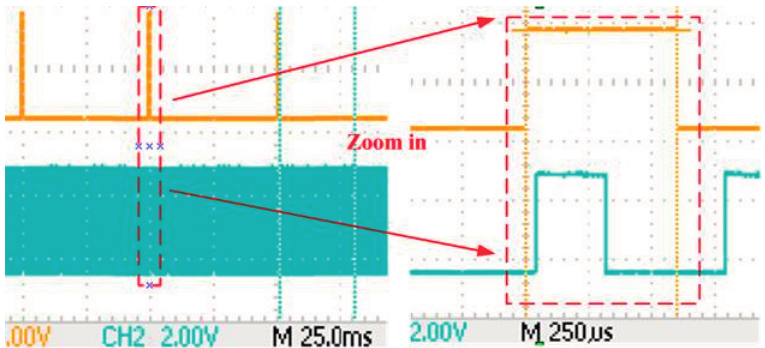
Figure 13. Time delay of the INS aiding